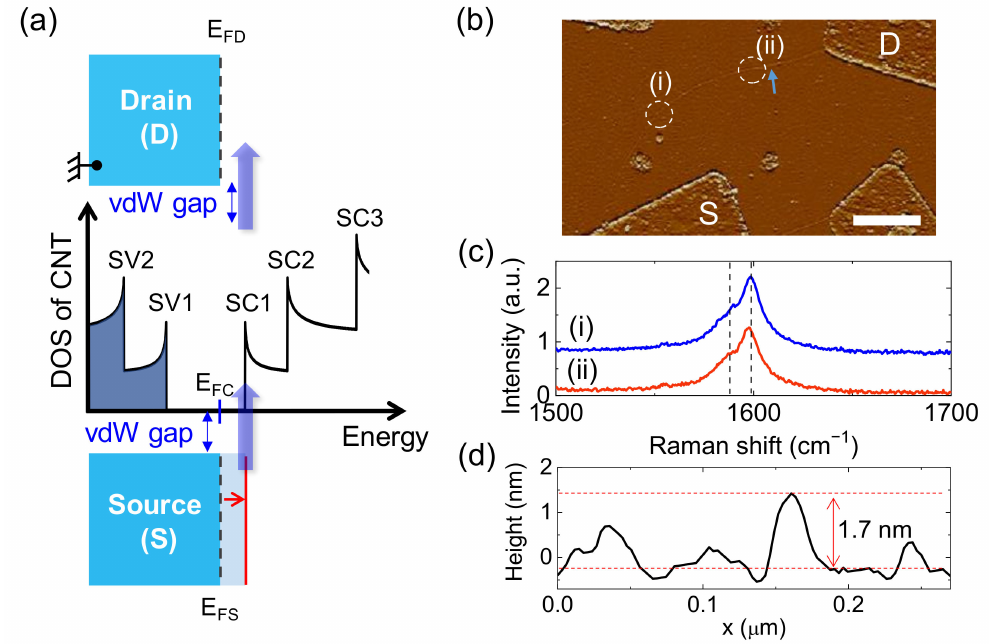
Figure 1. ( a ) Schematic illustration of the electronic DOS of an MWCNT with two indium electrodes. E FD , E FS and E FC are the Fermi energies of the drain (D), the source (S) and the CNT, respectively. The solid red lines represent E FS at a finite negative V sd , where E FS is aligned with SC1 in the CNT and results in an enhancement of the conductance, as indicated by the blue arrow. ( b ) AFM image of a representative sm -DWCNT FET device prepared on a 500 nm thick SiO 2 /Si substrate. The scale bar represents 1 µ m. ( c ) Raman signals obtained from circled regions (indicated by (i) and (ii) in ( b )), which show a main peak at 1598 cm − 1 as a G peak with a satellite peak at 1586 cm − 1 . ( d ) Height profile along the direction of the blue arrow in ( b